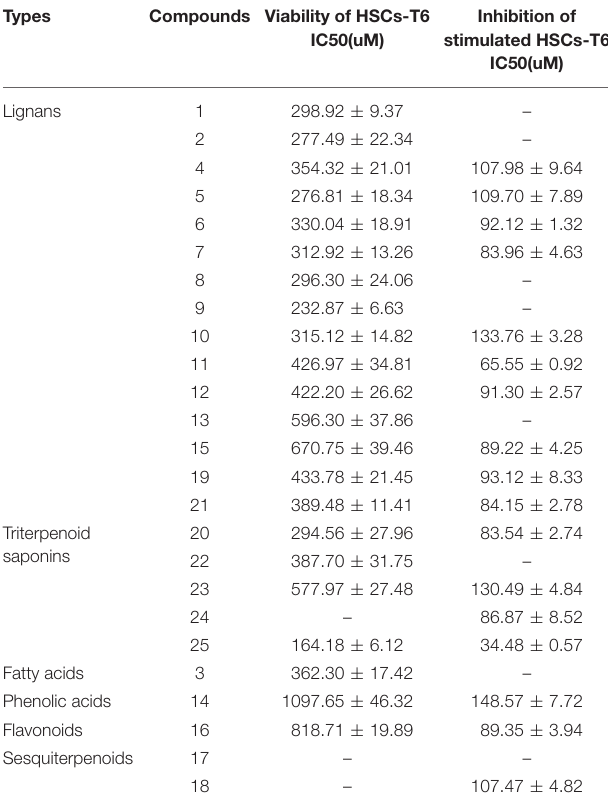
TABLE 2 | Effects of compounds 1 - 25 from ZYCH on HSC-T6 cells( x ±